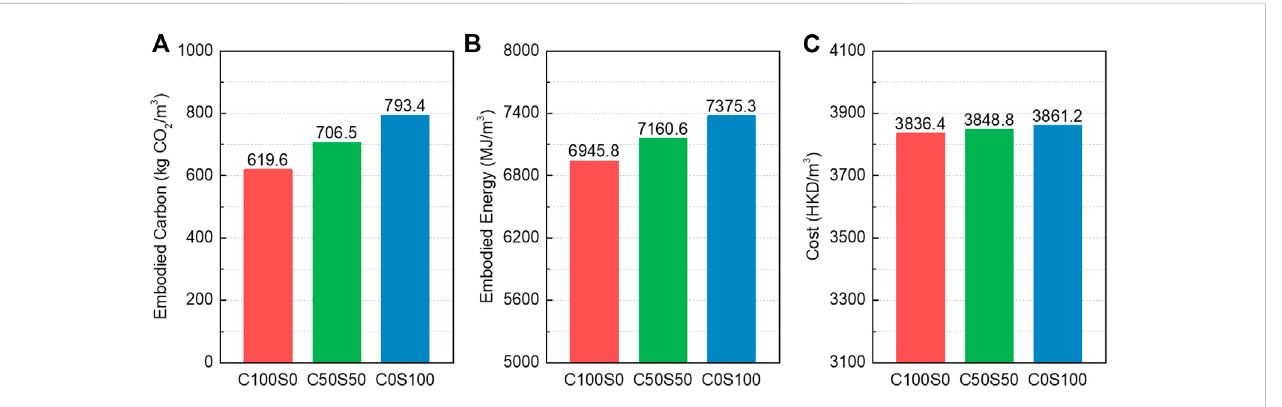
FIGURE 11 Environmental impacts and economical potentials of SH-UHPGC: (A) Embodied carbon, (B) embodied energy, and (C) material costs.